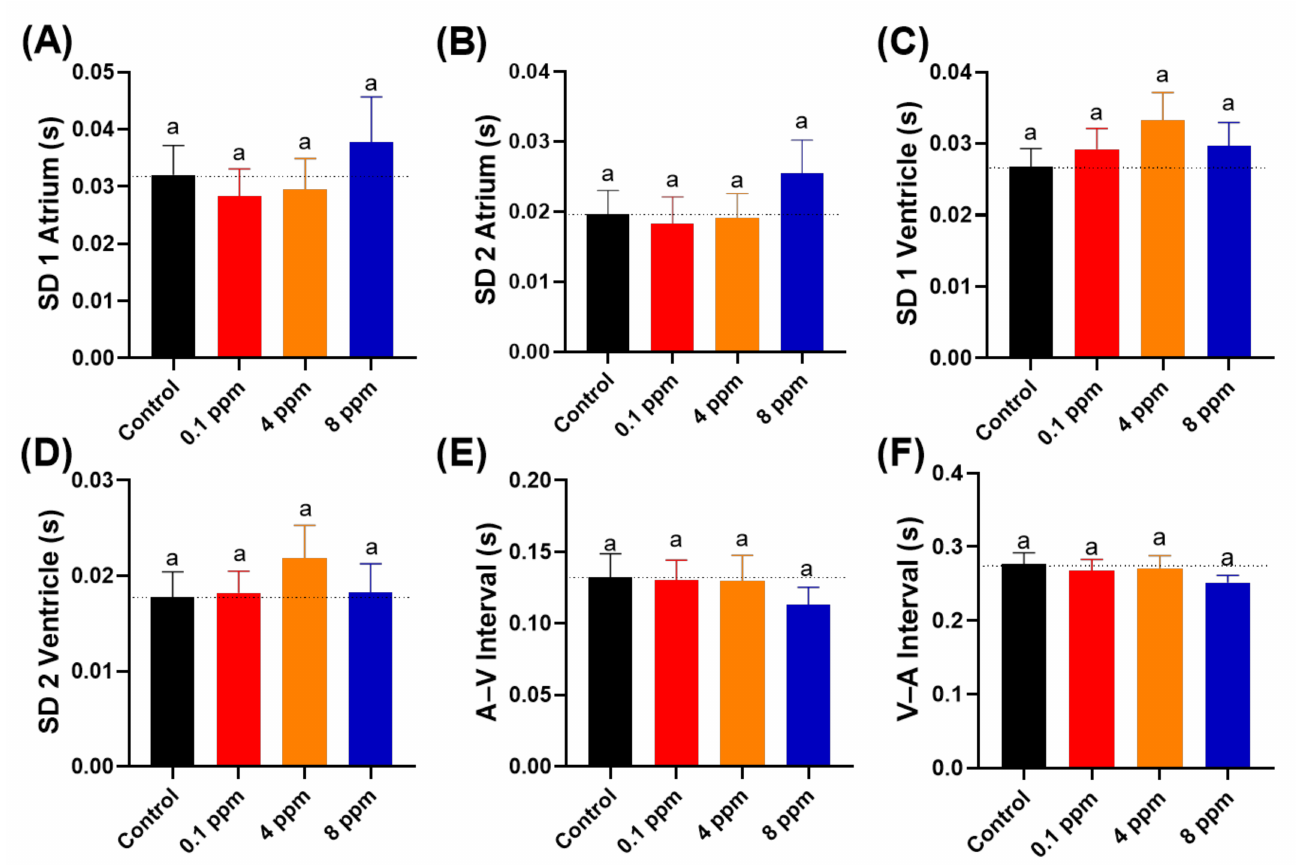
Figure 4. Cardiac rhythm analysis of zebrafish larvae at 72 hpf after 24-h exposure to different doses of RAC. Several important parameters like ( A ) SD1 of Poincare plot in atrium, ( B ) SD2 of Poincare plot in atrium, ( C ) SD1 of Poincare plot in ventricle, ( D ) SD2 of Poincare plot in ventricle, ( E ) A–V Interval and ( F ) V–A Interval were measured and compared. The data are expressed as the means ± SEM and were analyzed by Kruskal–Wallis test followed with Dunn’s multiple comparisons test ( n = 27). Same letter ‘a’ above columns indicate no significant statistical differences with p > 0.05. Black bar: control, red bar: RAC 0.1 ppm, orange bar: RAC 4 ppm, and blue bar: RAC 8